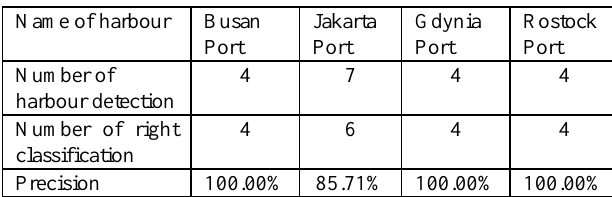
Figure 3. Jakarta Port in Indonesia